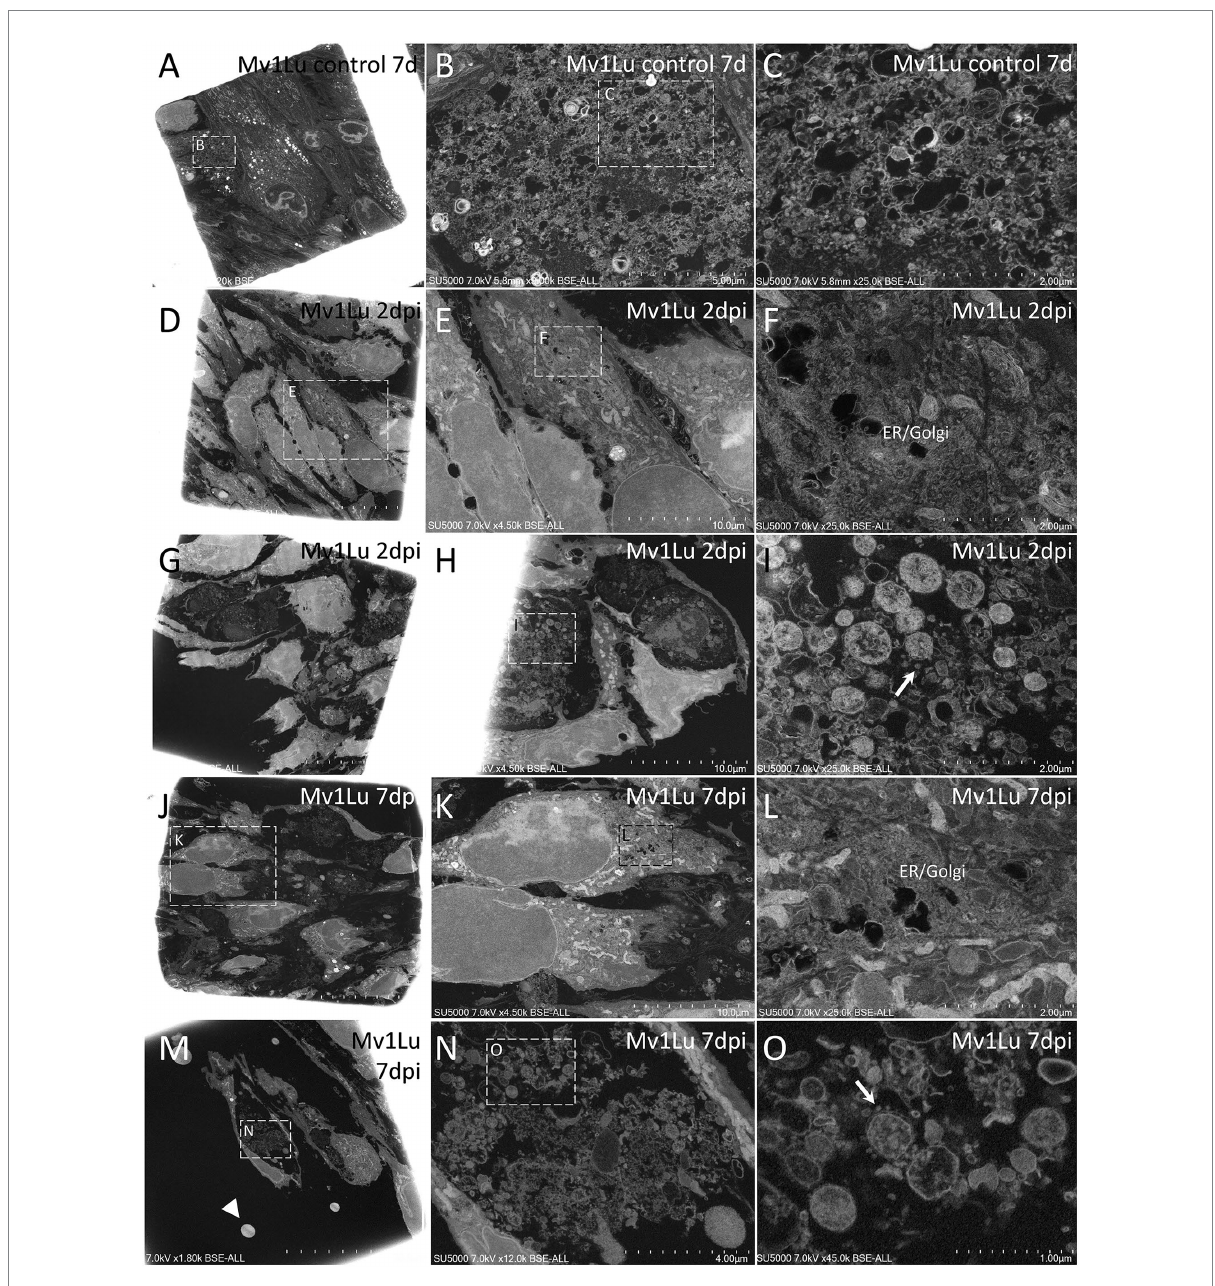
FIGURE 3 Scanning electron microscopy of SARS-CoV-2-infected Mv-1-Lu cell monolayer ultra-thin sections. (A) Low-magnification view of control, 7 days non-infected Mv-1-Lu cells monolayer. (B) Zoom-in boxed region in (A) with material between non-infected cells. (C) Zoom-in boxed region in (B) , with dense or empty objects, with diameters generally below 60 nm and above 140 nm. (D) Low-magnification view of Mv-1-Lu cell monolayer mostly intact at 2 d.p.i with SARS-CoV-2. (E) Zoom-in infected Mv-1-Lu cell boxed in (D) . (F) Zoom-in boxed region in (E) with an extended endoplasmic reticulum/Golgi apparatus. (G) Low-magnification view of Mv-1-Lu cell monolayer at 2 d.p.i with SARS-CoV-2 with lytic cells. (H) Lytic debris of 2 d.p.i infected Mv-1-Lu cells located among intact cells inside the monolayer. (I) Zoom-in boxed region in (H) with SARS-CoV-2 virions (arrow) located among extracellular cell debris. (J) Low-magnification view of Mv-1-Lu cell monolayer at 7 d.p.i with SARS-CoV-2 with lytic cells. (K) Zoom-in boxed region in (J) with two intact cells. (L) Zoom-in boxed region in (K) with an extended endoplasmic reticulum/Golgi apparatus. (M) Low-magnification view of Mv-1-Lu cell monolayer at 7 d.p.i with lytic debris and hyperdense nuclei (arrowhead). (N) Lytic debris from boxed region in (M) . (O) Zoom-in boxed region in (N) with SARS-CoV-2-like particles (arrow) among lytic